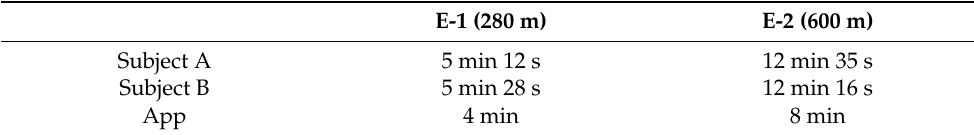
Table 3. Experiment 2: Navigational times for the two environments.